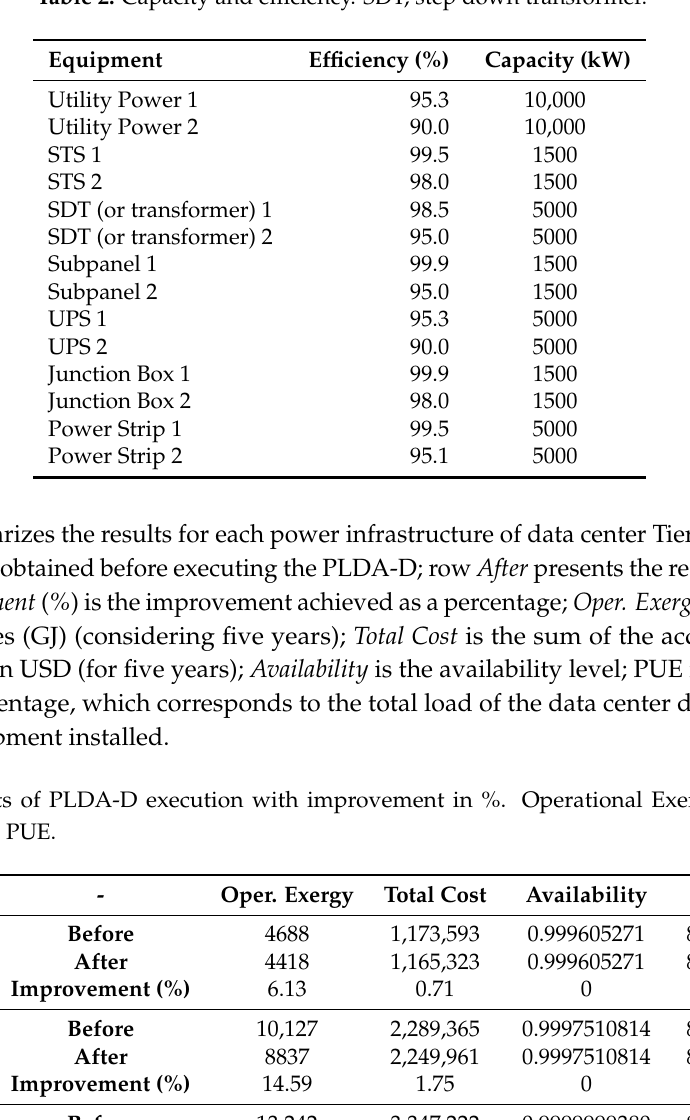
Table 2. Capacity and efficiency. SDT, step down transformer.